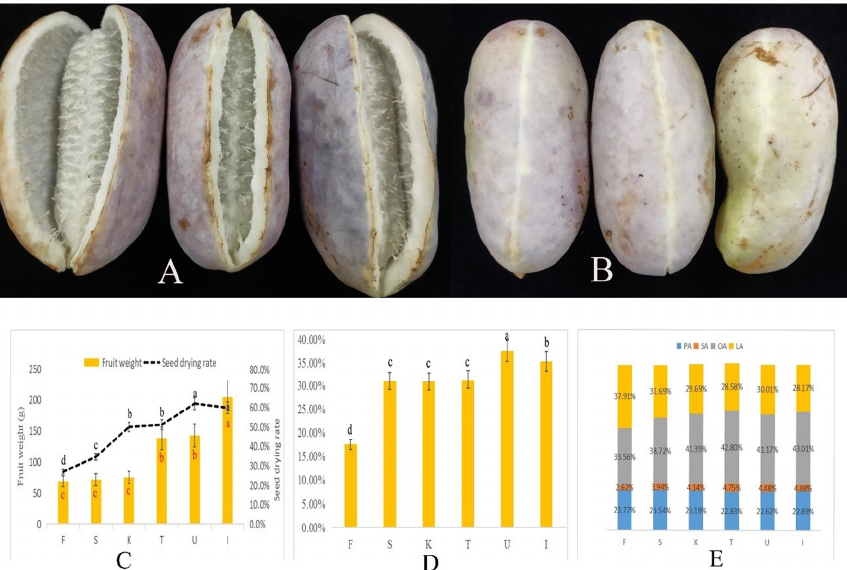
Figure 1. Morphological characteristics and oil content during A. trifoliata seed development. ( A ) Ripe fruits. ( B ) Unripe fruits. ( C ) Dynamic changes in fruit weight and seed drying rate. ( D ) Dynamic changes in ASO content. ( E ) Dynamic changes in the four main ASO components. The different letters (a, b, c...) represent significance at p ≤ 0.05. Figure 1D shows the dynamic changes in ASO content, which peaked (37.76% of seed weight) at 180 DAF; however, there was no significant change in its content between 135 and 165 DAF. There was a decreasing trend in its content between 180 and 195 DAF. ASO was found to contain 11 FA types, with the main FAs being palmitic acid (PA), stearic acid (SA), OA, and LA, which accounted for over 97% of ASO (Table 1), while the other seven FAs accounted for less than 1% of ASO. The FA types present in ASO did not change with seed development, and only their relative content changed. Among the four main FAs that constitute ASO, OA and LA exhibited the most significant changes (Figure 1E). LA content decreased from 37.91% to 28.17%, and with seed development, its relative content gradually decreased. OA content increased from 33.56% to 43.01%, and the trend in its change was opposite to that of LA. There was no significant change in PA content, and SA content increased from 2.62% to 4.75%. Table 1. Average content of ASO composition in developing A. trifoliata seeds. Different letters rep- resent significance at p ≤ 0.05 Compositions (%)